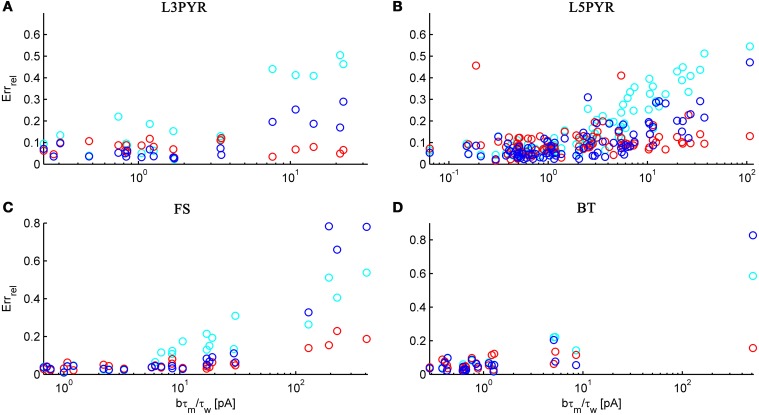
The relative prediction error for the full FP, the EIF-〈w〉 and the EIF-F(w) approach as a function of b · τm/τw. The error is shown for layer-3 pyramidal cells (A), layer-5 pyramidal cells (B), fast-spiking (C) and bitufted (D). Cyan: EIF-〈w〉, blue: full FP, red: EIF-F(w). Pearson correlation (cyan, blue, red): (0.89, 0.86, −0.26) (A), (0.74, 0.74, 0.14) (B), (0.87, 0.94, 0.89) (C), (0.89, 0.97, 0.51) (D). Error averaged over σIsyn ∈ {100, 200, 300, 400, 500, 600} pA and μIsyn = cell-specific rheobase.